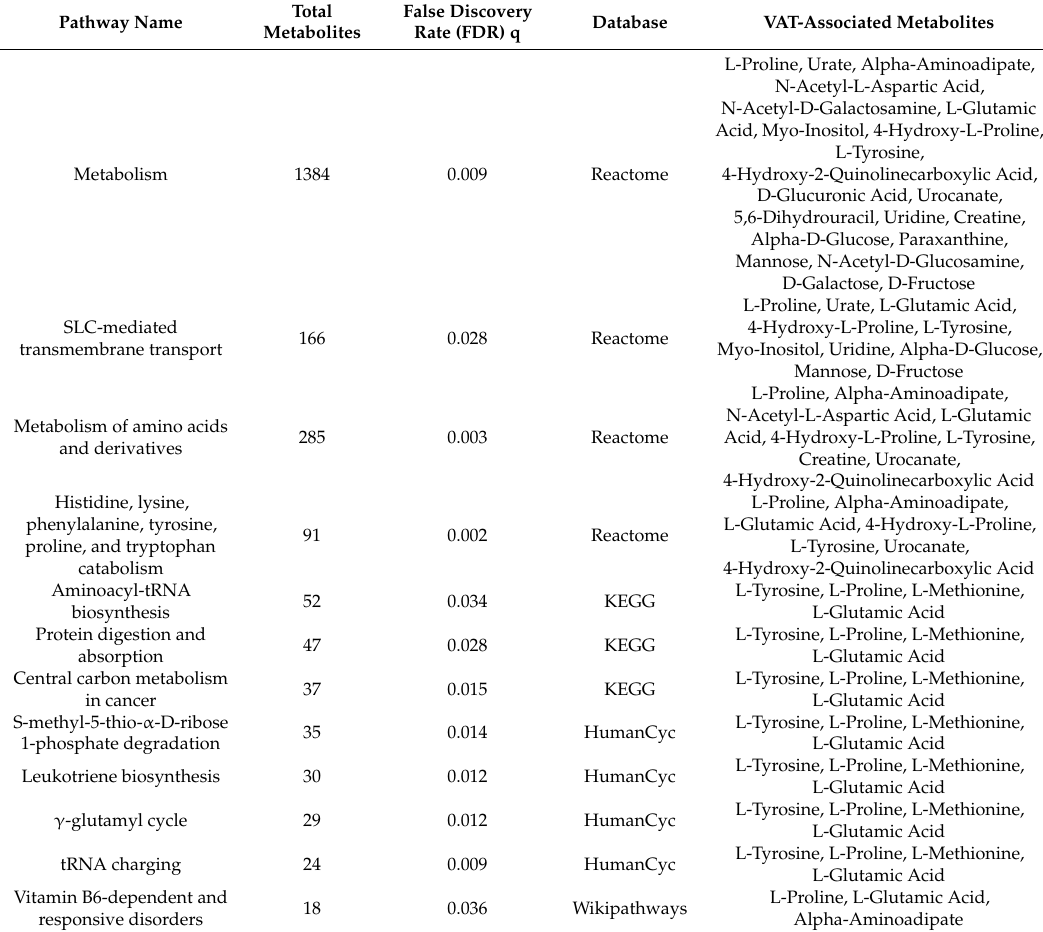
Table 2. Pathways significantly enriched for metabolites associated with change in visceral adipose tissue